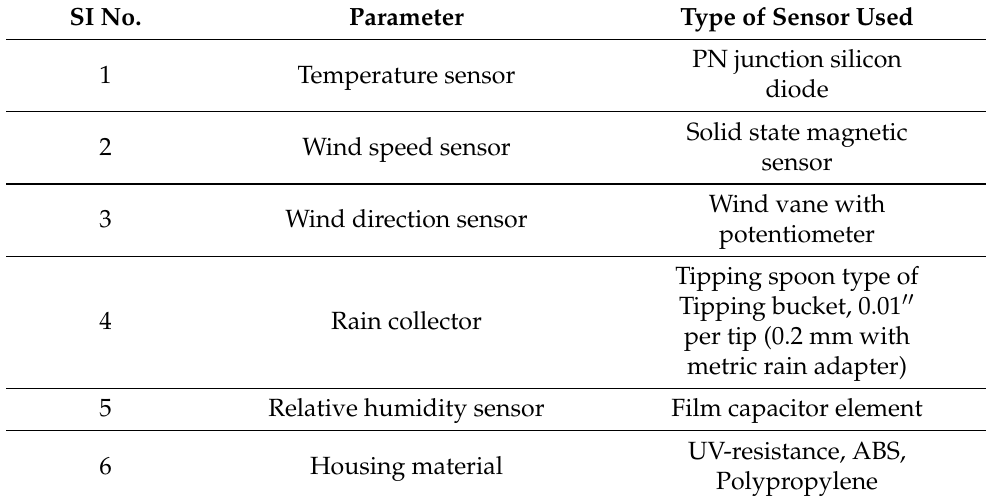
Table 4. The Sensor Suite Consistency.